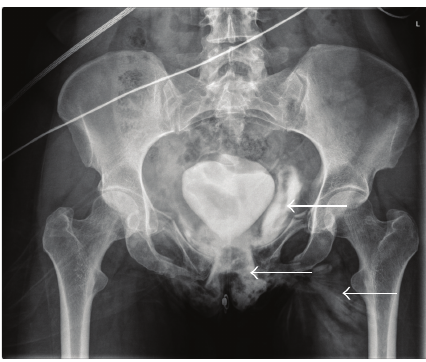
Figure 1: Severe extravasation of contrast solution into the soft tissues is shown (white arrows), yet demonstrating an intact bladder. In the presence of a longitudinal urethral injury contrast solution runs freely into the surrounding soft tissues. The bladder is “pushed up” by a large pelvic haematoma.